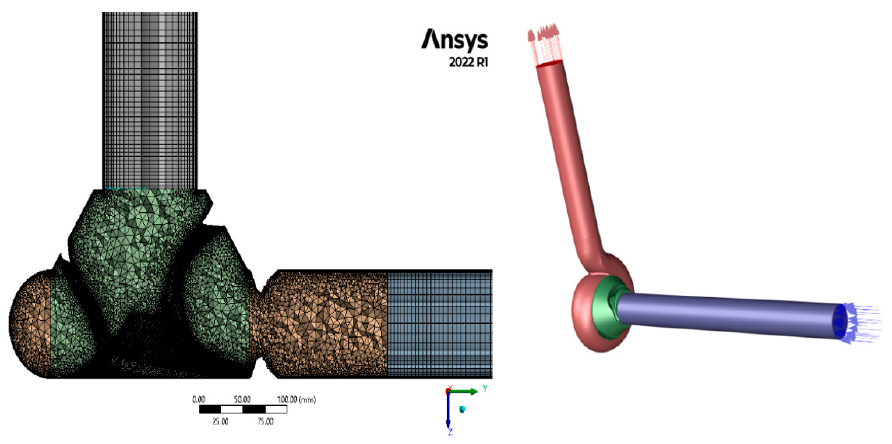
Figure 3. Mesh and modelled computational domains.